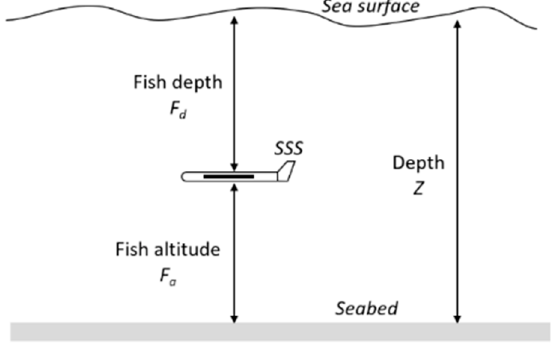
Figure 5. Operational parameters of the towed side-scan sonar.